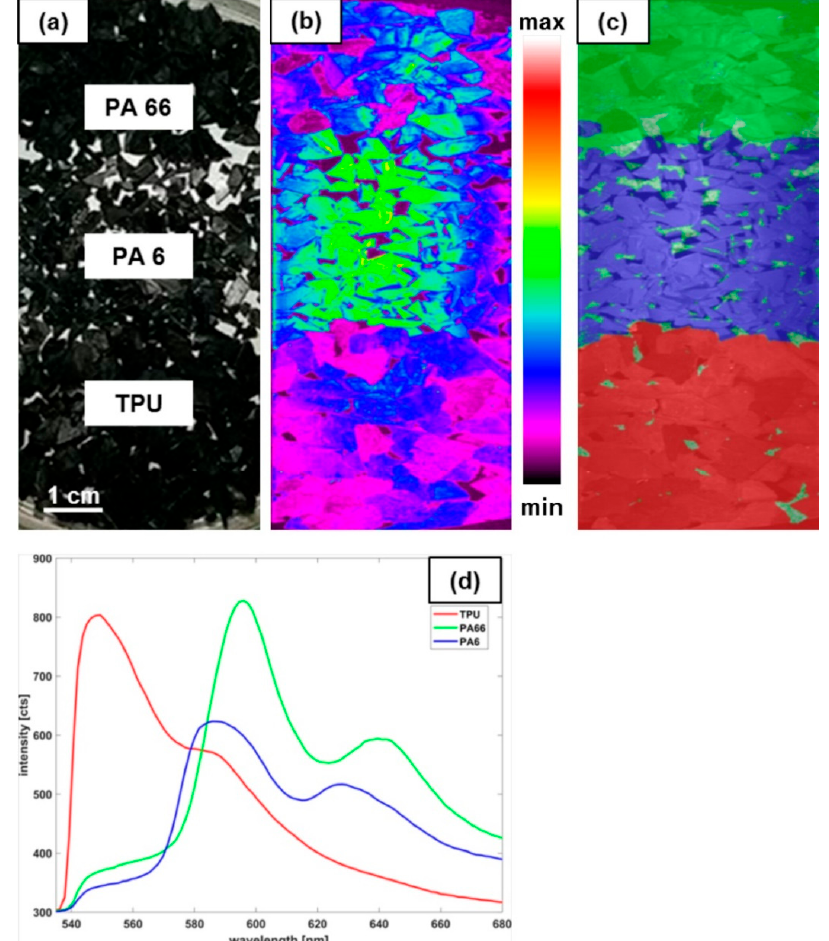
Figure 4. Laser-HSI measurement of the black polymer samples. ( a ) Picture of the sample showing the different kind of black polymer particles. ( b ) False color image of the measured intensity at 580 nm. ( c ) Classification result of the Laser-HSI measurement (green = PA66 (polyamide 66); blue = PA6 (polyamide 6); red = TPU (thermoplastic polyurethane). ( d ) Example spectra of the three black